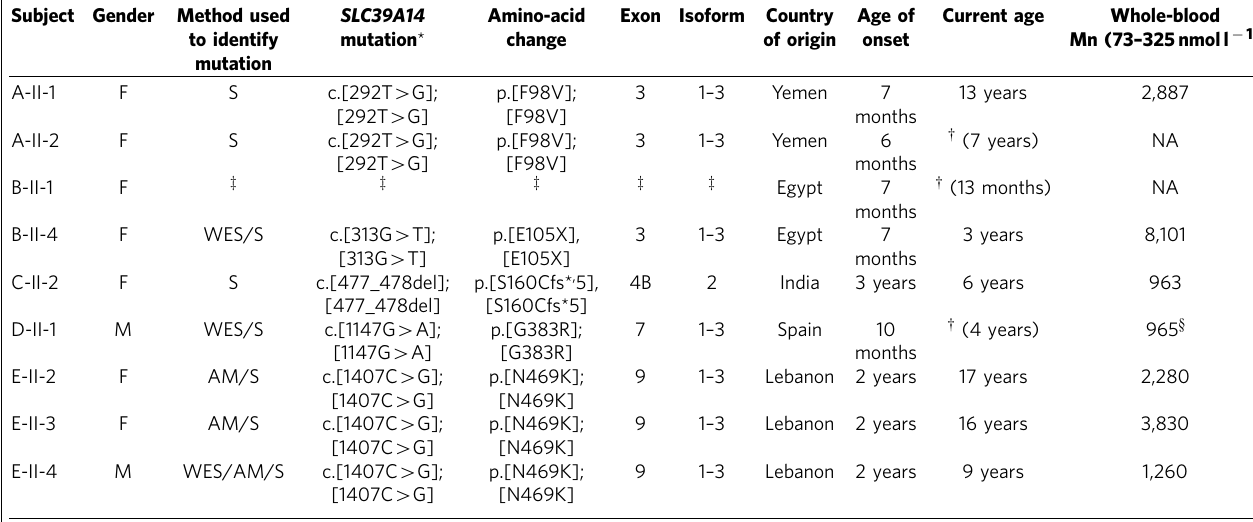
Table 1 | Clinical characteristics and SLC39A14 mutations identified in affected patients.